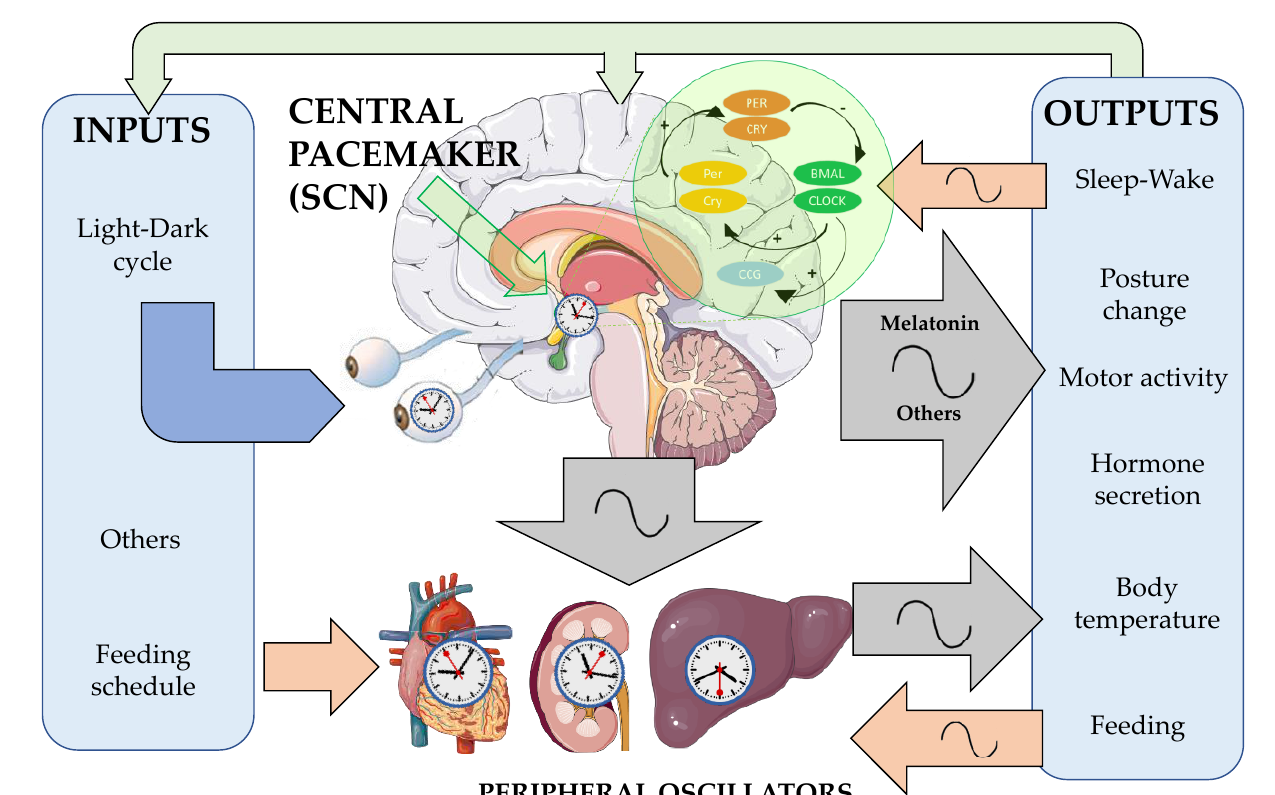
Figure 4. Schematic organization of the circadian system, with the central pacemaker located in the suprachiasmatic nuclei (SCN) and peripheral oscillators in most organs and tissues. The system presents inputs, with the light–dark cycle being the most important synchronizer. Sleep–wake cycle, hormone secretion, and body temperature are just some of the outputs of the circadian system. These outputs can act on the clock itself or modify the inputs in a feed-back manner. The molecular clock machinery is also represented in the greenish circle, with the positive (BMAL and CLOCK) and negative (PER and CRY) elements, also affecting the expression of clock-controlled genes (CCG). Modified from Garaulet and Madrid (2009) [219]. This figure was built with SMART resources (Servier Medical Art), licensed under a Creative Common Attribution 3.0 Generic License. See http://smart.servier.com/.